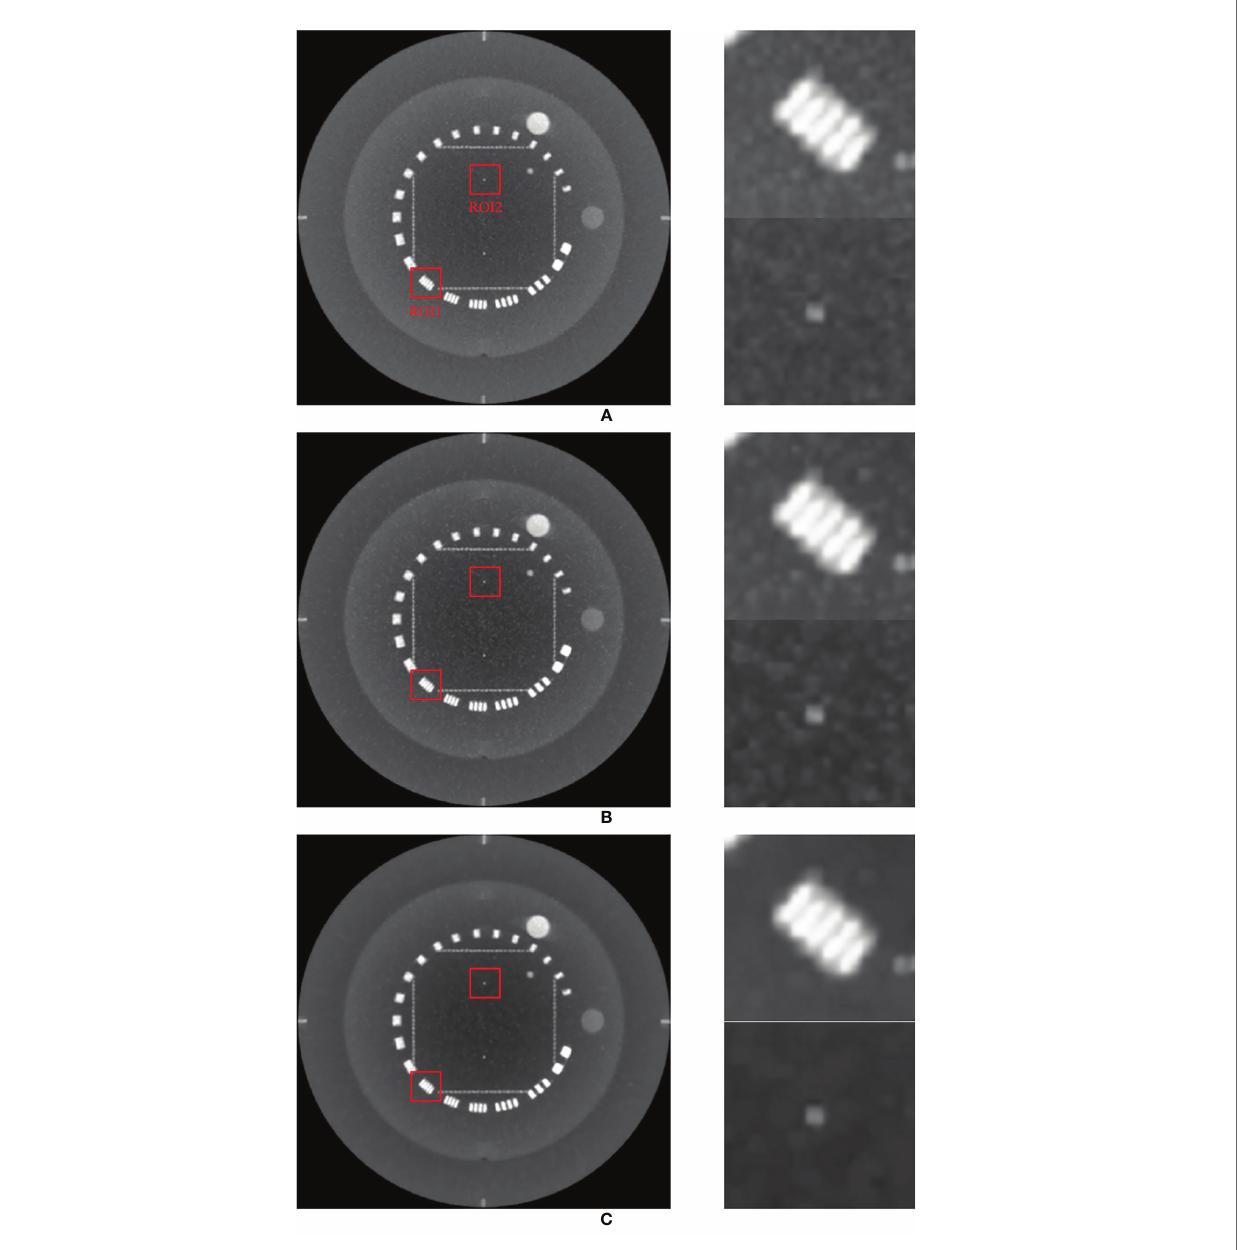
FIGURE 4 | Comparison of maximum intensity projections (MIPs) of the CBCT images generated by applying analytical reconstruction algorithm based on (A) RDB, (B) RDB followed by NLTV, and (C) RDB followed by MI-NLTV using the Catphan ® 503 phantom. These images are displayed at the window (width and level) settings of (1,500, 500)